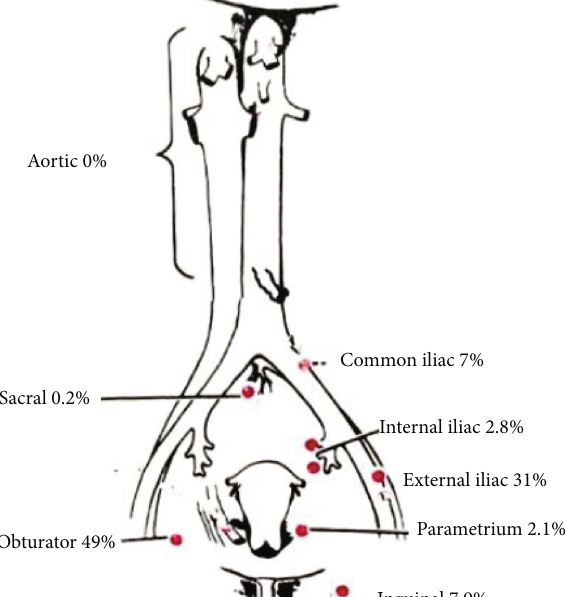
Figure 1: Localization and status of pelvic nodes and SLNs (the picture is taken from the book “ Clinical Gynecologic Oncology ”